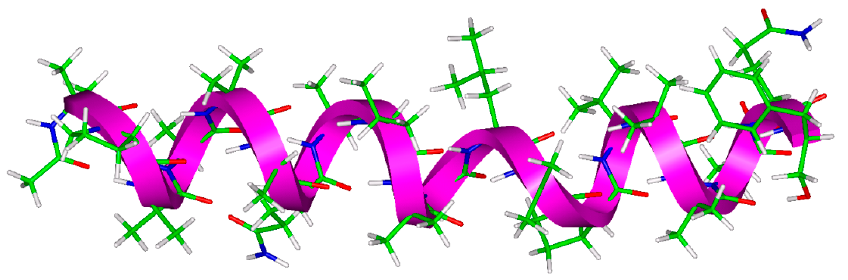
Figure 2. The asymmetric unit of ALM-18 model, shown together with an irregular helix. Color-coding of the sticks: white, green, blue, and red for hydrogen, carbon, nitrogen, and oxygen atoms, respectively. The helix is depicted as magenta solid ribbon.